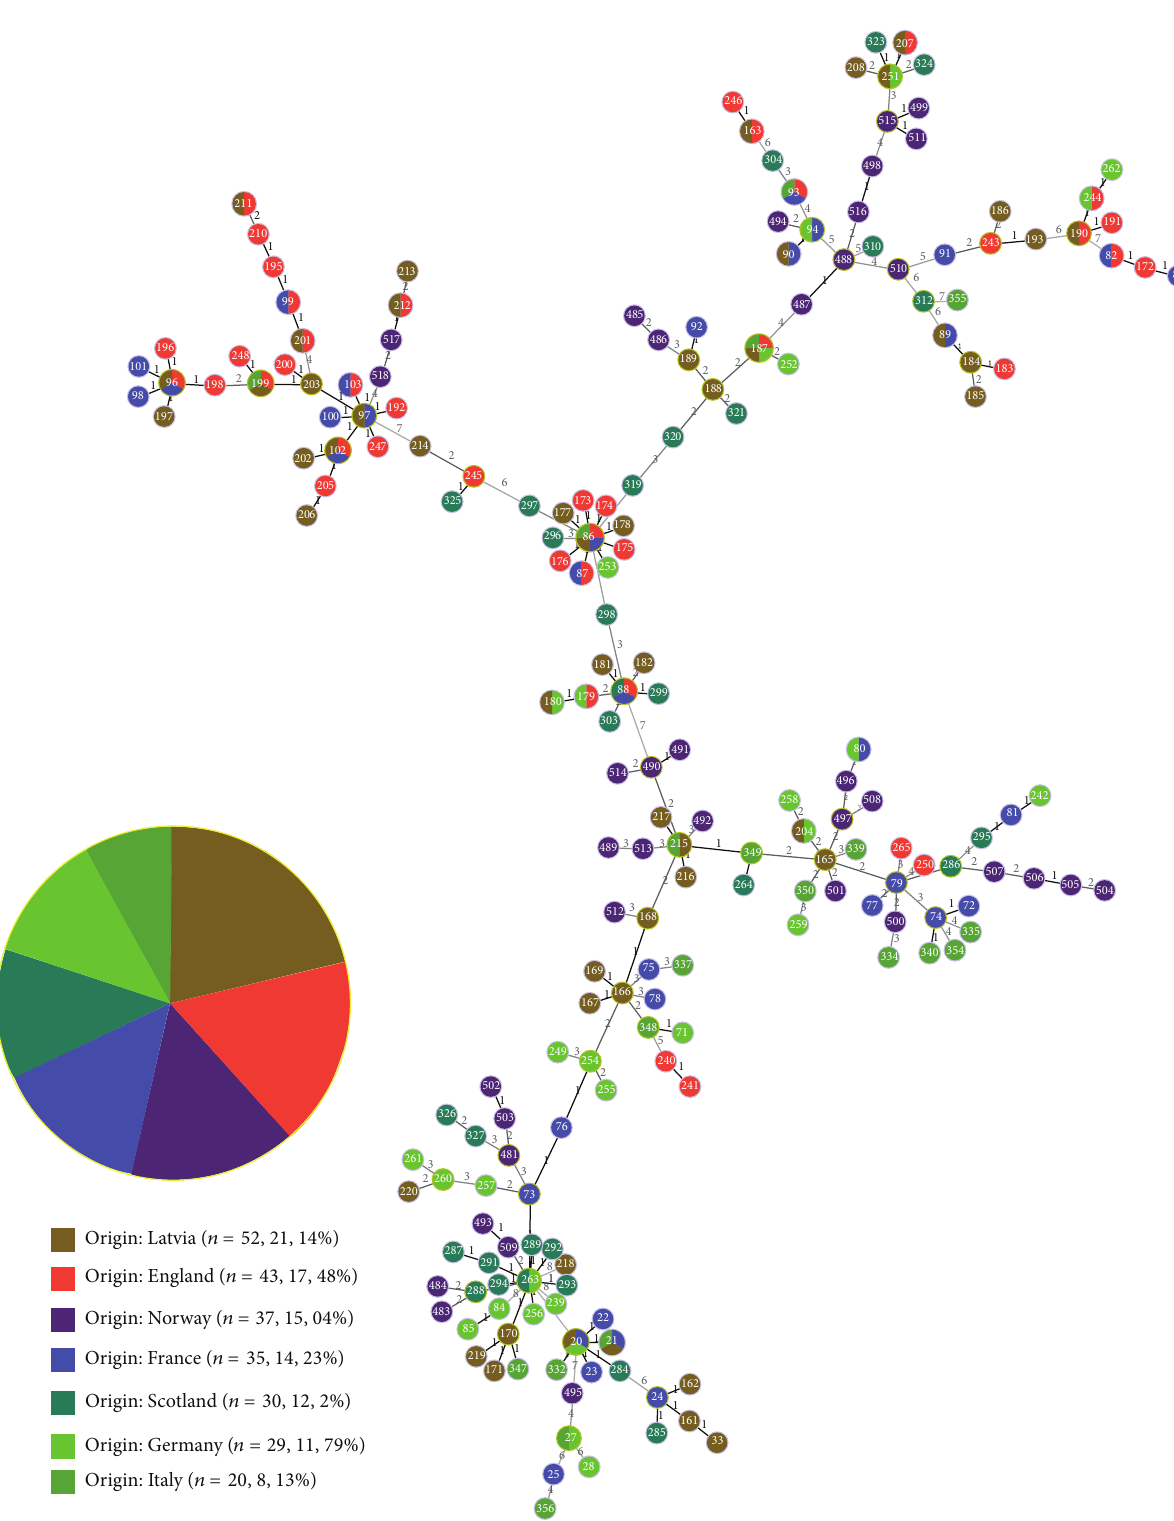
Figure 4: goeBURST. The goeBURST is coloured based on the geographic origin of each ST. Multiple colours indicated multiple